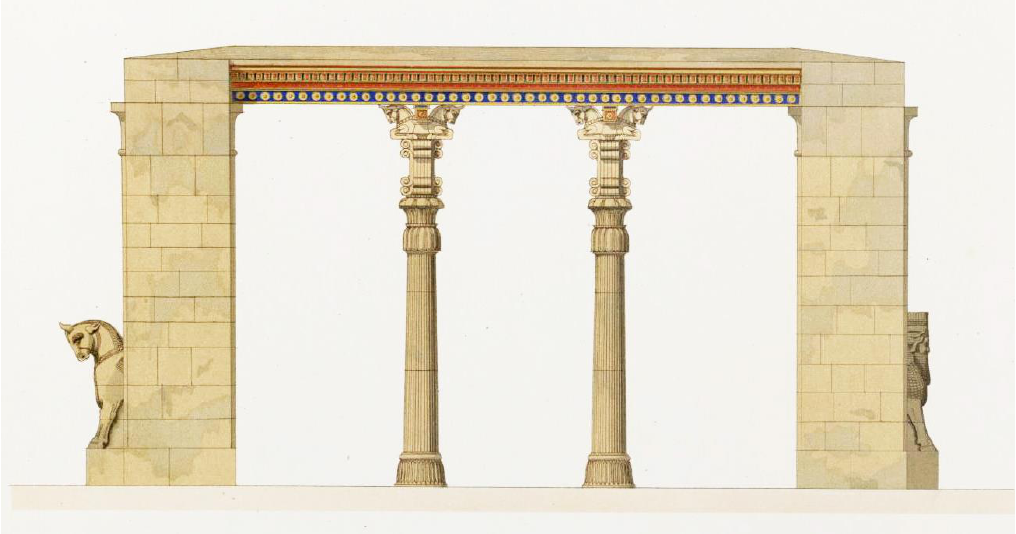
Figure 8. Lateral façade of the Gate, reconstructed and published by Flandin and Coste. The animal motifs are facing towards the west–east direction ([38] (Plate. 87)). Source: Bibliothèque Nationale de France.